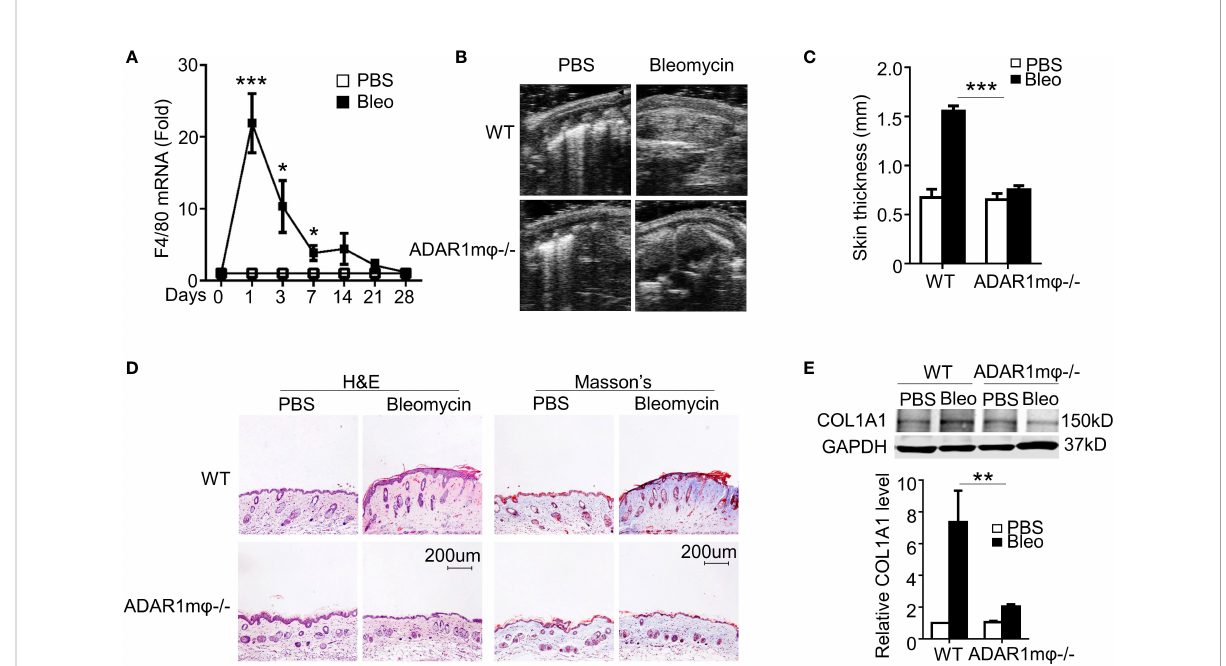
FIGURE 2 ADAR1 de fi ciency in macrophages (ADAR1m j -/- ) ameliorated skin sclerosis formation. (A) Mice were injected s.c. with bleomycin (Bleo: 0.02U) for the times indicated. Total RNA was extracted from skin tissues, and F4/80 mRNA levels were detected by RT-qPCR. *P<0.05, ***P<0.001 vs PBS-treated group for each isoform. (B) ADAR1m j -/- attenuated bleomycin-induced skin fi brosis compared with WT mice. Skin sections were collected 28d after bleomycin injection, and skin thickness was measured by ultrasonography and indicated by arrows. (C) Quanti fi cation of the skin thickness in bleomycin-treated WT and ADAR1m j -/- mice. ***P<0.001 vs. PBS control, n = 6. (D) ADAR1m j -/- inhibited bleomycin-induced collagen deposition in skin, as shown by Masson ’ s trichrome staining. H&E staining showed skin structure. 20x power of objective lens was used to acquire the images. (E) ADAR1 deletion blocked bleomycin-induced COL1A1 expression in skin tissues, as determined by Western blotting. COL1A1 protein levels were quanti fi ed by normalizing to GAPDH. **P<0.01, n = 6. 2-way ANOVA was used for comparison among